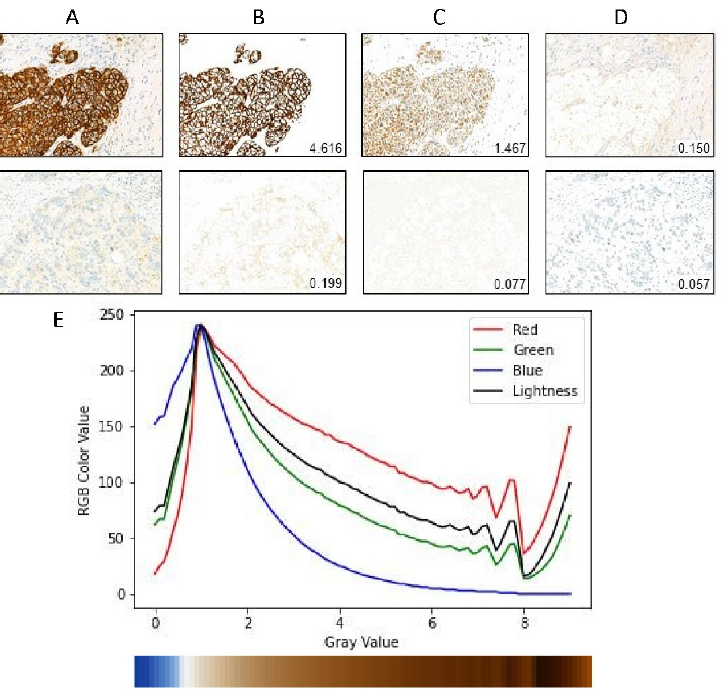
Figure 2. Cell membrane segmentation and the schematic of Graymap. ( A ) raw section of HER2 3+ and HER2 0/1+. ( B – D ) are three groups of K-Means output. The gray values are labeled on the images respectively. ( E ) The mean RGB value of different gray value membrane pixels. The bottom color bar is an RGB color map of different gray values.